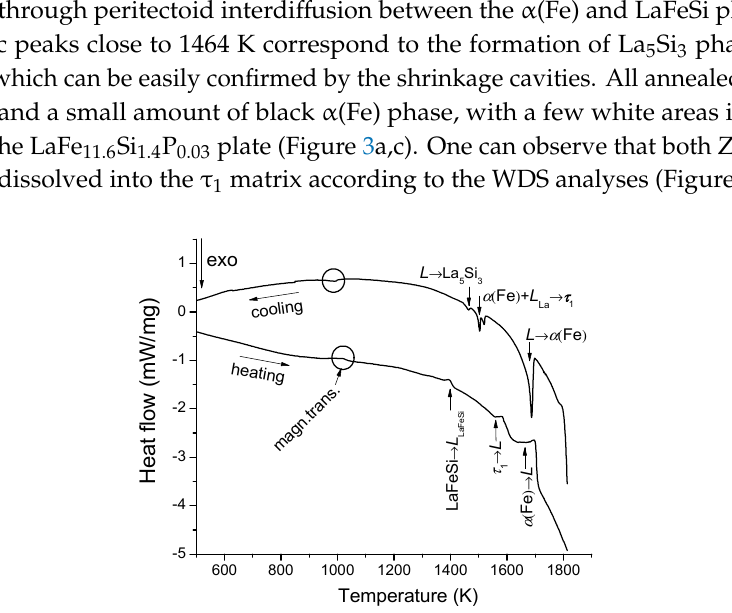
Figure 2. High-temperature differential scanning calorimetry (DSC) chart of the sub-rapidly solidified LaFe 11.6 Si 1.4 plate with a heating / cooling rate of 20 K / min.